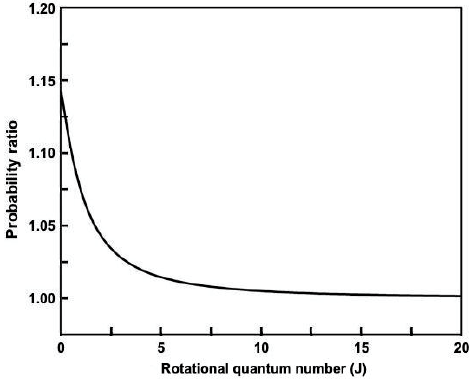
Figure 2. The ratio of absorption to emission probability of microwave radiation from molecular rotational states as a function of the rotational quantum number J . Resonance of microwave radiation with the rotational levels of water clusters or resonances via microwave adiabatic tunnelling is responsible for microwave energy trapping between the rotational energy levels of water clusters, causing biological stress during the interaction of EMR with biological matter.